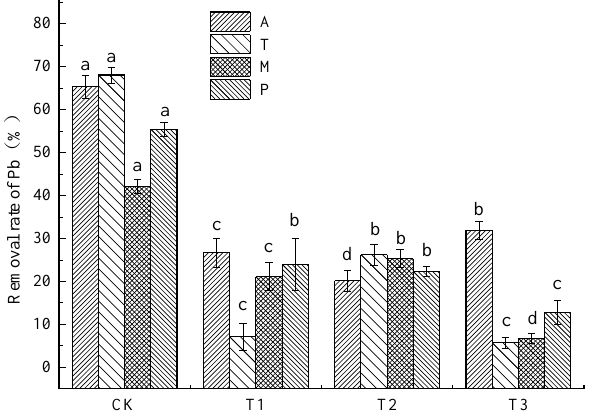
Figure 5. The removal rate of Pb in soil under different treatments. Means ± SE with different letters indicate significant difference according to LSD testing ( p < 0.05).